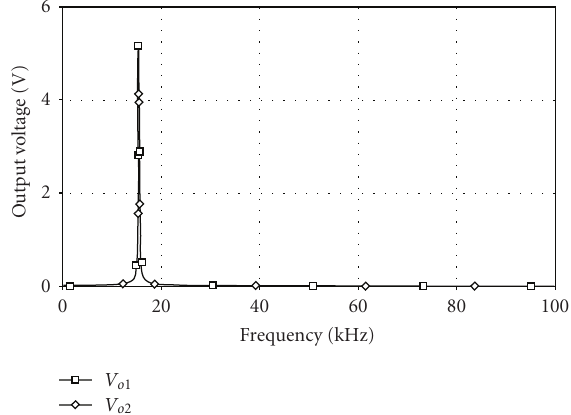
Figure 10: Experimental output waveforms V o 1 and V o 2 of the pro- posed oscillator of Figure